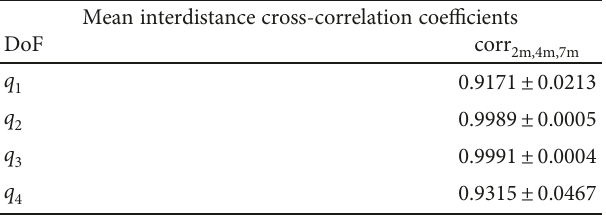
Figure 9: Representative joint space strategy for all subjects f . Computed by averaging joint features across subjects for each DoF. Solid Q ,All lines are the average values and dashed lines the standard deviation values. The joint space analysis focused on the following degrees of freedom of the throwing arm: shoulder internal/external rotation and shoulder, elbow, and wrist fl exion/extension ( q 1 t , q 2 t , q 3 t , and q 4 t , resp.). Angles are given in degrees. Table 3: Mean intersubject and interdistance cross-correlation coe ffi cients. The representative joint space strategy shown in Figure 9 was correlated across throwing